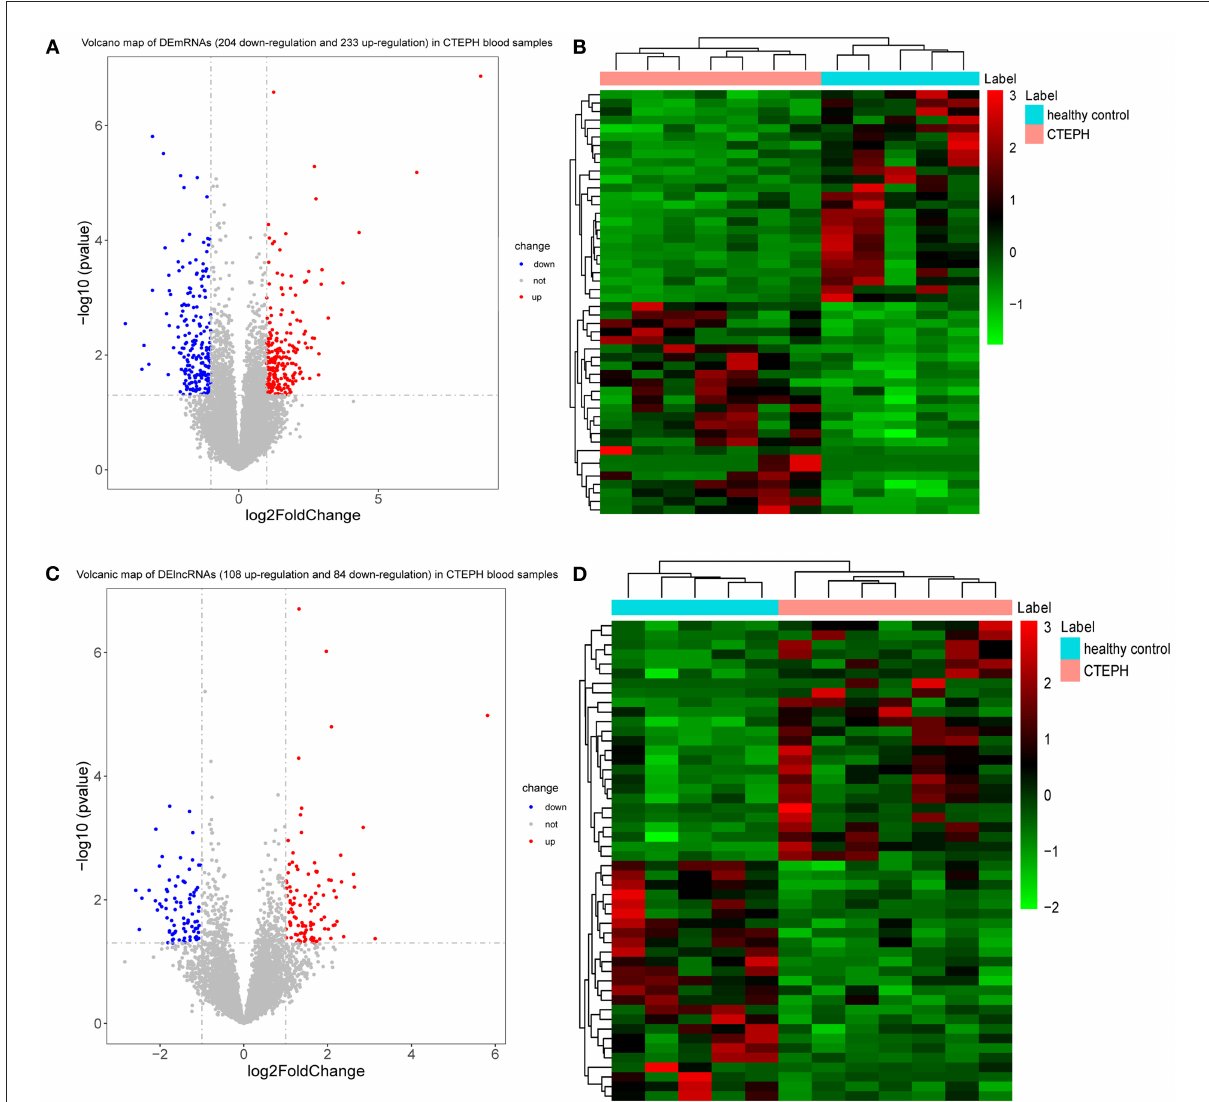
FIGURE1 DEmRNAs and DElncRNAs analysis. (A) Volcano map of DEmRNAs. X-axis and Y-axis presents -log10 ( p -value) and log2fold change, respectively. Blue and red colors represent downregulation and upregulation, respectively. (B) Heat map of top 50 DEmRNAs. The clustering is constructed using the full chain method together with the Euclidean distance. Red indicates above the reference channel (high expression genes). Green indicates below the reference channel (low expression genes). (C) Volcano map of DElncRNAs. X-axis and Y-axis presents -log10 ( p -value) and log2fold change, respectively. Blue and red colors represent downregulation and upregulation, respectively. (D) Heat map of top 50 DElncRNAs. The clustering is constructed using the full chain method together with the Euclidean distance. Red indicates above the reference channel (high expression genes). Green indicates below the reference channel (low expression genes). p -Value < 0.05 and |log2 fold change| (|log2FC|) > 1 were used to the differential expression screening criteria of lncRNAs and